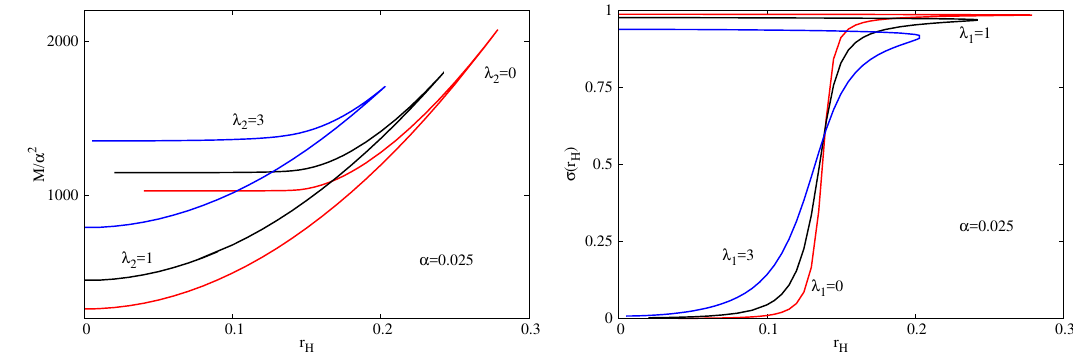
Figure 14 . The mass M (left panel) and the parameter (cid:27) ( r H ) (right panel) are shown for spherical BHs with Skyrme hair, as a function of the horizon radius for several values of (cid:21) 2 and a (cid:12)xed (cid:11)